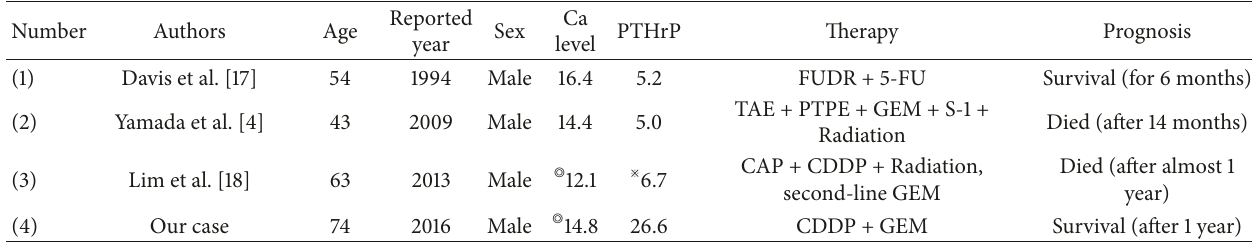
Table 2: Reported cases of cholangiocarcinoma secreting PTHrP who are alive for more than half a year.